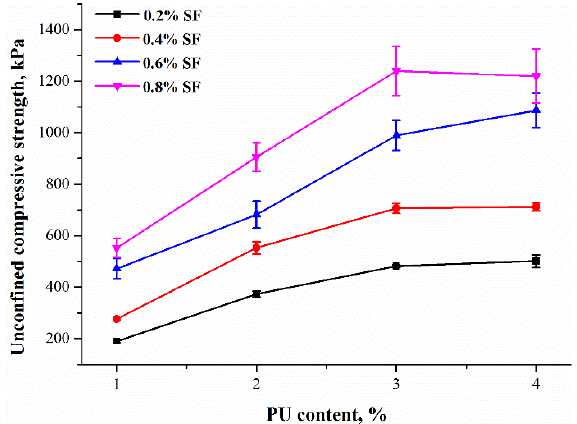
Figure 6. The relationship between the UCS and PU content.